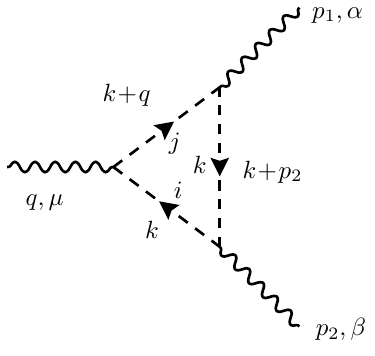
Figure 2 . Contribution to the Z 3 vertex (cid:0)